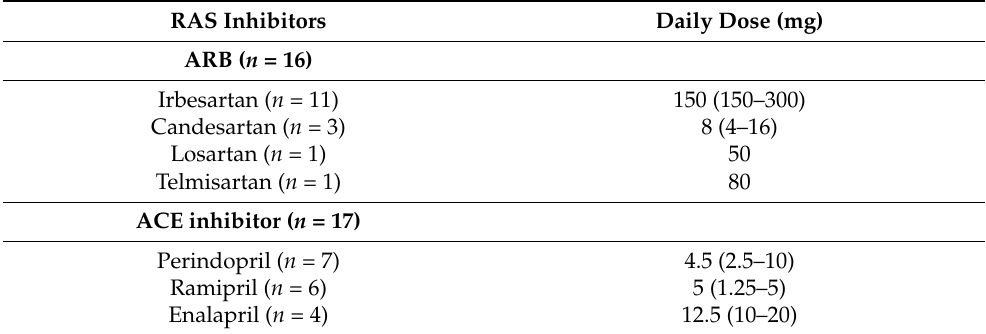
Table 2. RAS inhibitors used and the daily dose (median (min-max)).